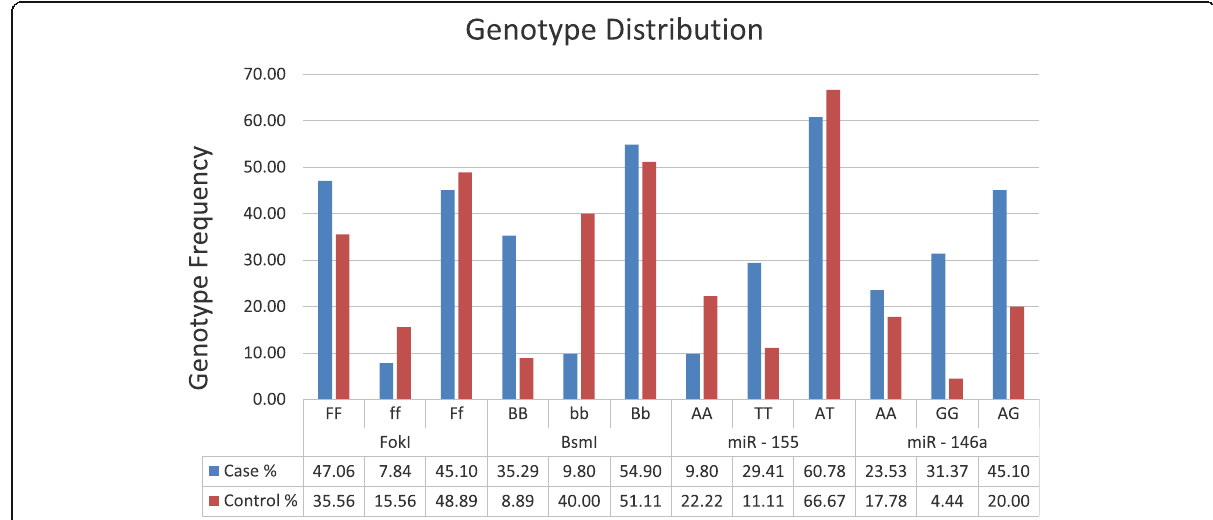
Fig. 2 Genotype distribution of patients with BD and controls for the four SNPs